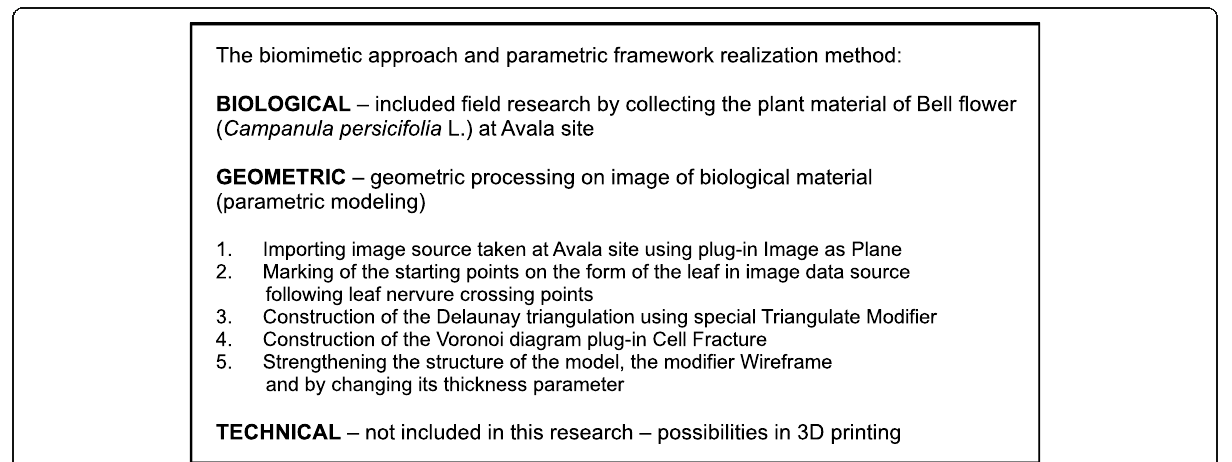
Fig. 4 Framework of the method used in this